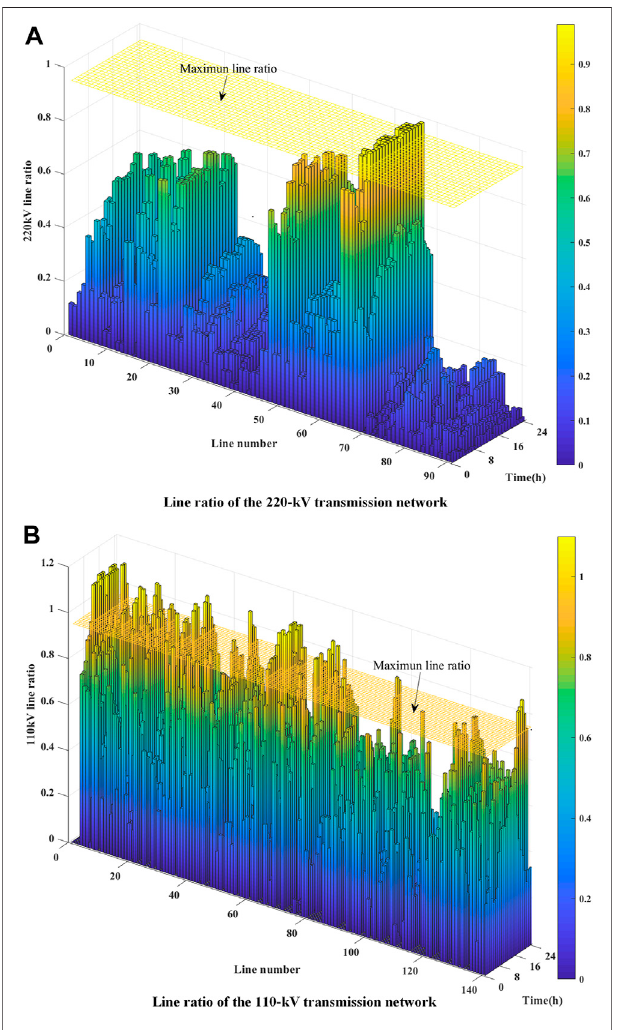
FIGURE 10 | System operation condition. (A) line ratio of the 220-kV transmission network. (B) line ratio of the 110-kV transmission network.